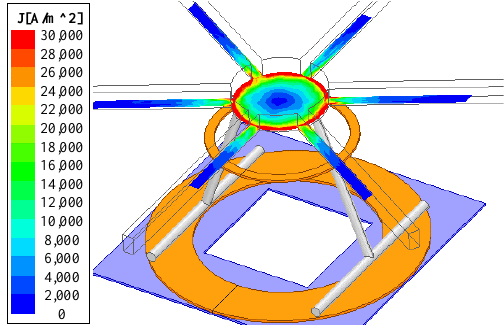
Figure 2. Eddy current distribution of carbon fiber fuselage.